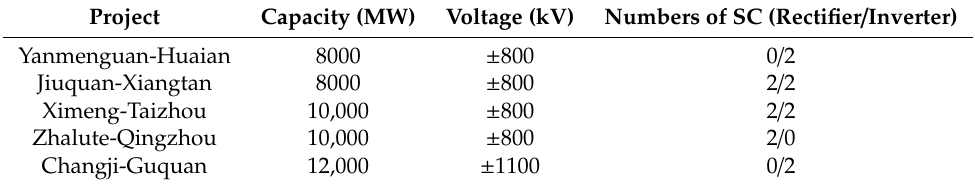
Table 1. Practical projects equipped with a synchronous condensers